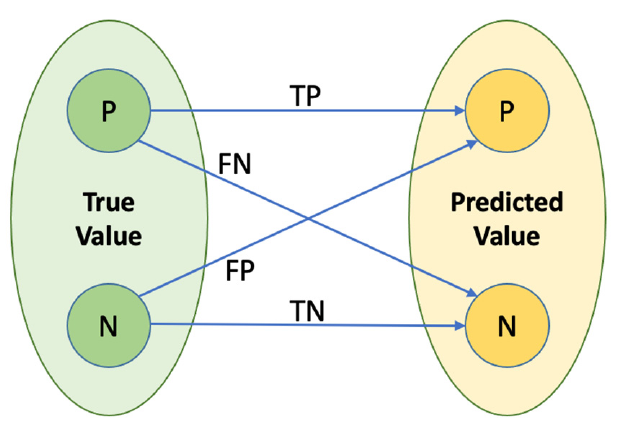
Figure 2. Change in state quantity.